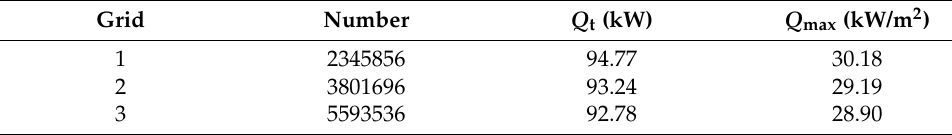
Figure 4. Heat flux distribution of nose cone. Table 3. Total heat flux and peak heat flux.